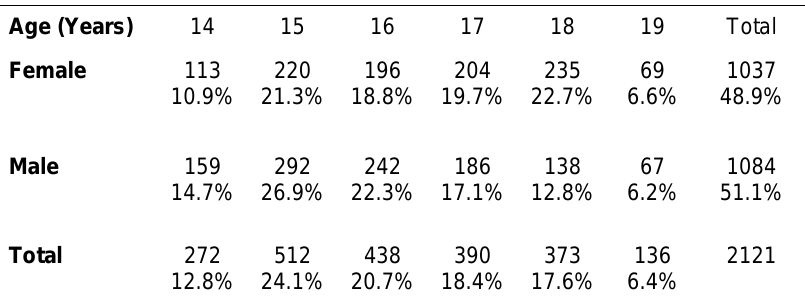
Participants Age and